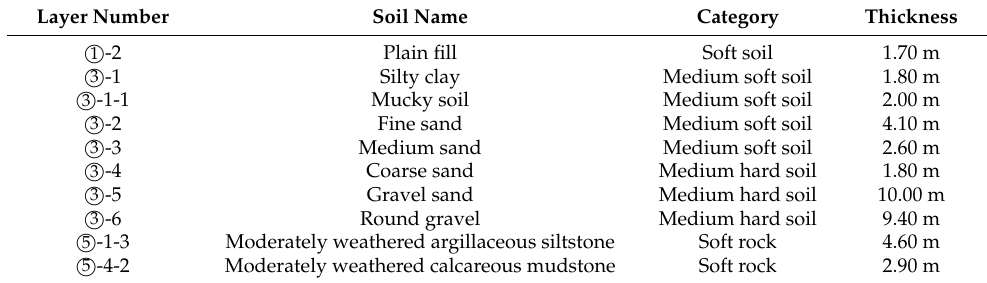
Table 1. Stratum distribution parameter.